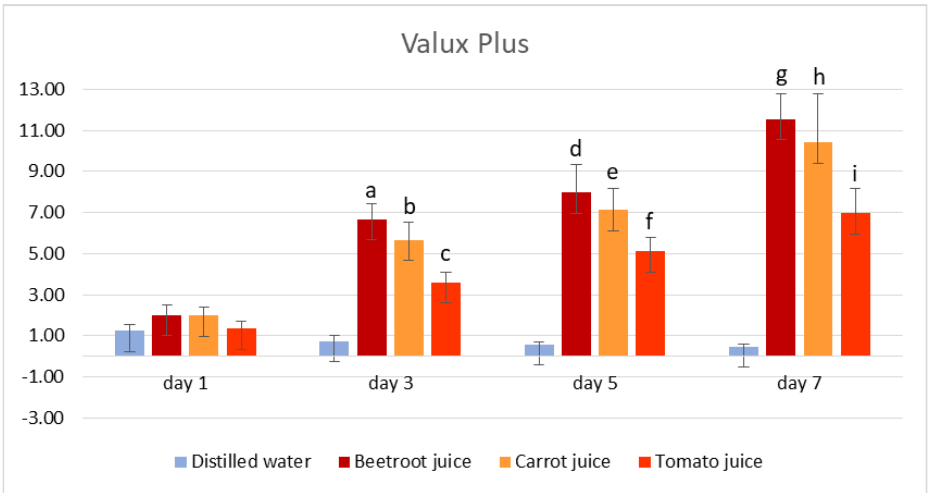
Figure 2. Colour change (mean values ± standard error of mean) for Valux Plus samples. A lowercase letter indicates a statistical difference between the mean discolouration of samples immersed in distilled water and that of samples immersed in vegetable juice at each time point (e.g., “b” indicates a statistical difference between the mean discolouration of samples immersed in distilled water and that of samples immersed in carrot juice for 3 days).